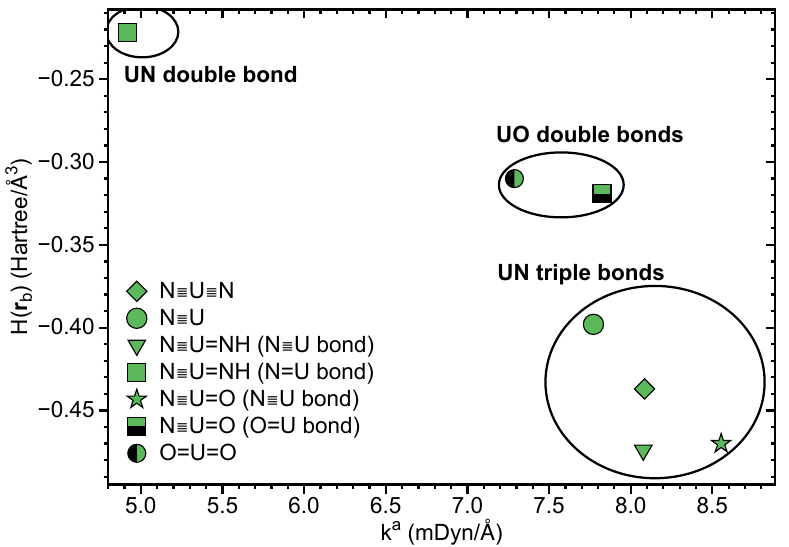
Figure 5. Correlation between H( r b ) and k a for UN and UO bonds. NESCau/PBE0//cc-pwCVTZ-X2C (uranium) and NESCau/PBE0//cc-pVTZ (N,O,H) level of